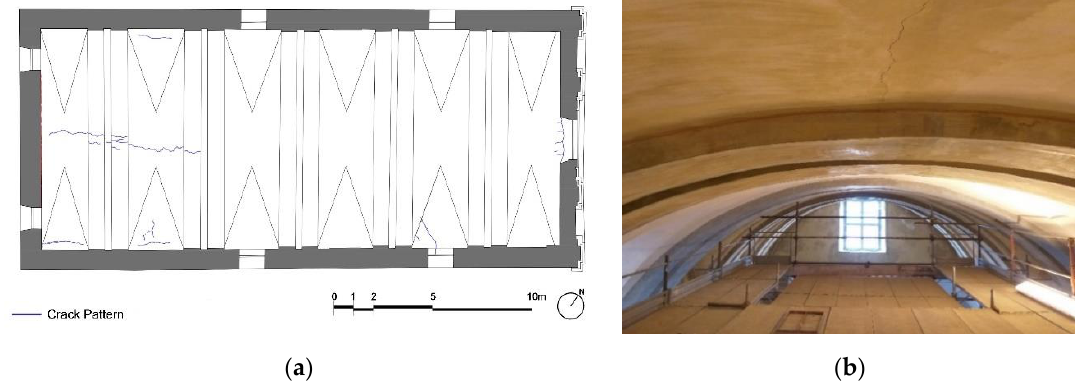
Figure 11. St. Marta church: ( a ) plan of the barrel vault and ( b ) irregular masonry barrel vault observed from the scaffold at a height of about 9 m. A longitudinal crack is visible at the center.